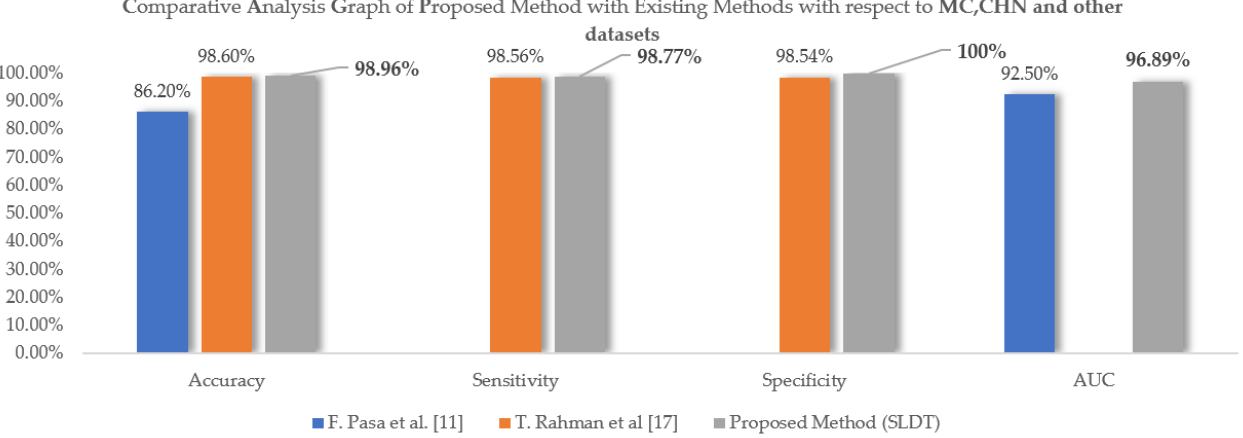
Figure 9. Comparative analysis graph of the proposed method with the existing method with respect to combined dataset 1 (MC and CHN).